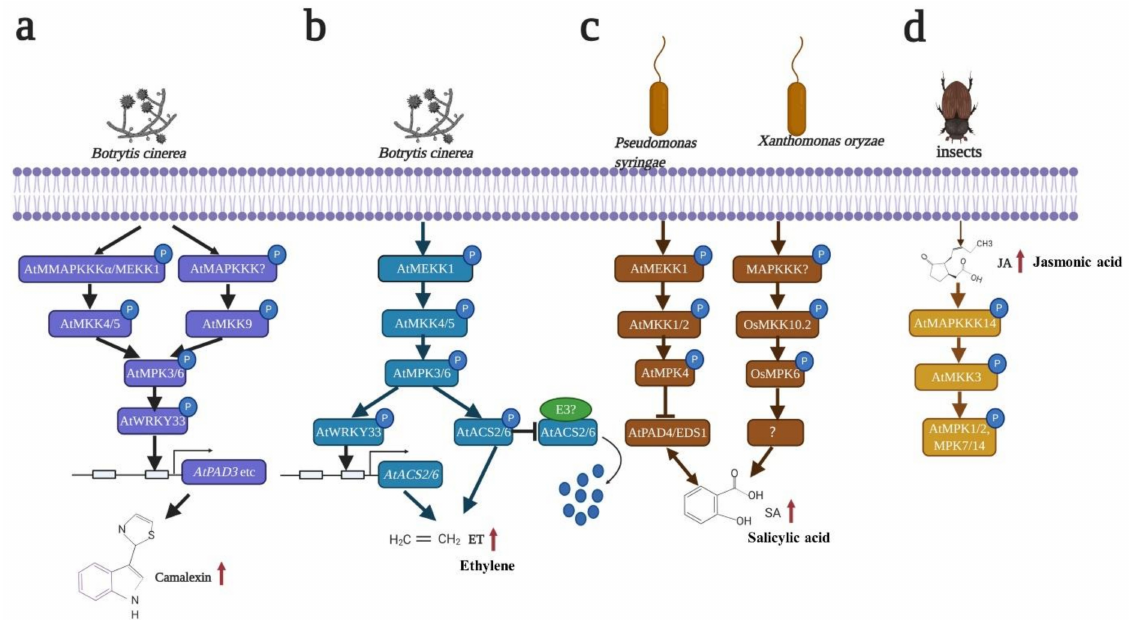
Figure 3. MAPK cascade function in biotic stress. ( a ) The MAPK cascade is involved in camalexin biosynthesis after Botrytis cinerea infection. ( b ) The AtMEKK1-AtMKK4/5-AtMPK3/6 cascade regulates ethylene (ET) production in two dependent ways. In one approach, AtMPK3/6 phosphorylates AtWRKY33, which can bind the promoters of AtACS2 and AtACS6 and activate AtACS2 and AtACS6 expression. In the other approach, AtMPK3/6 can directly phosphorylate AtACS2 and AtACS6, eventually promoting AtACS2 and AtACS6 stability. ( c ) AtMEKK1-AtMKK1/2-AtMPK4 negatively regulates salicylic acid (SA) production by negatively regulating AtPAD4 and AtEDS1 activities, whereas OsMKK10.2-OsMPK6 positively regulates SA production. ( d ) AtMAPKKK14-AtMKK3-AtMPK1/2/7/1 can be activated by jasmonic acid (JA) after insect feeding. The red arrows mean content increase. This figure was created using BioRender